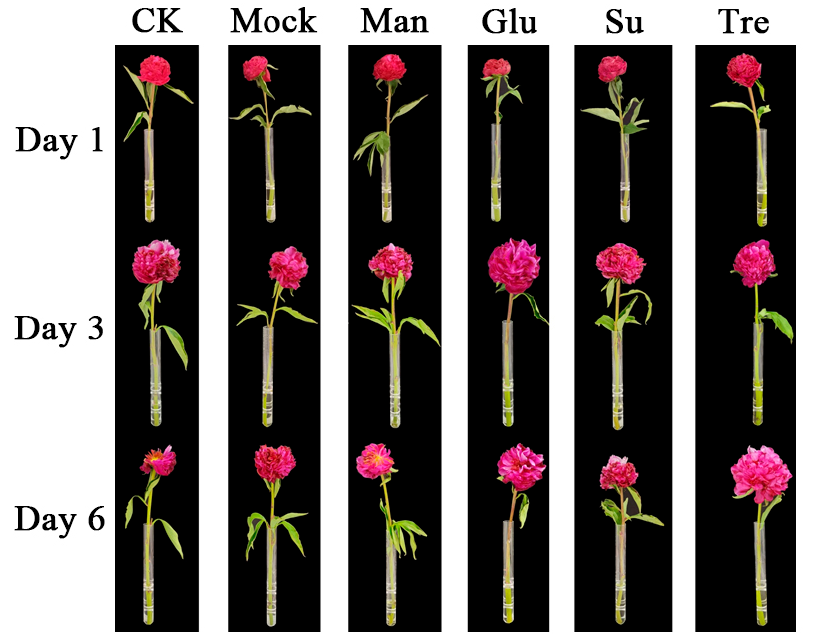
Figure 7. The appearance of flowering morphological changes of cut P. lactiflora in a fresh-keeping solution containing different carbon sources.